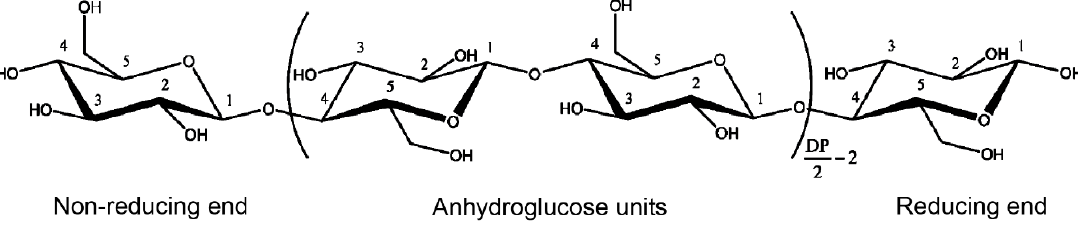
Figure 2. Chemical structure of cellulose (adapted from [11], with permission from © 2010 American Chemical Society).